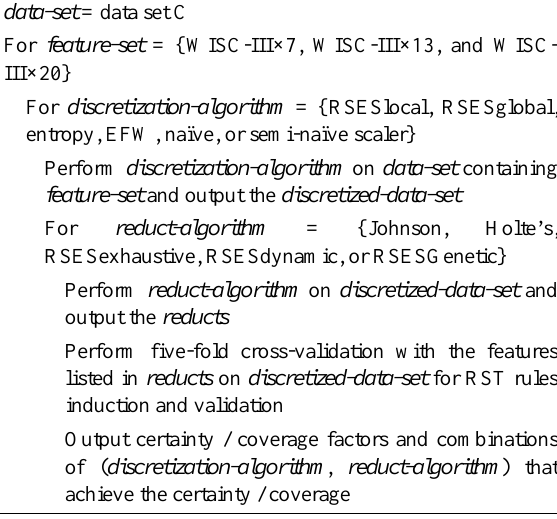
Table 3. Procedure of Experiment 2 data-set = data set C